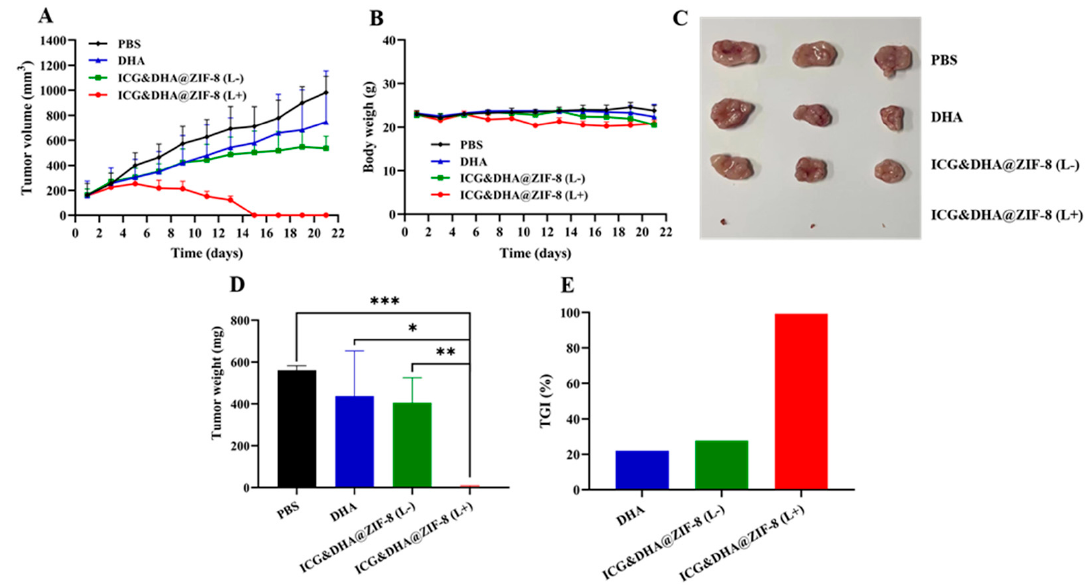
Figure 6. ( A , B ) Curves of tumor volume growth and body weight changes during the period of 21 days for all groups (“ICG&DHA@ZIF-8 (L − )” means ICG&DHA@ZIF-8 without laser irradiation, “ICG&DHA@ZIF-8 (L+)” means ICG&DHA@ZIF-8 with laser irradiation) ( n = 3). ( C , D ) Photos and weight of the tumors after all of the treatments ( n = 3). ( E ) TGI of the three treatment groups. * p < 0.05, ** p < 0.01, *** p < 0.001.